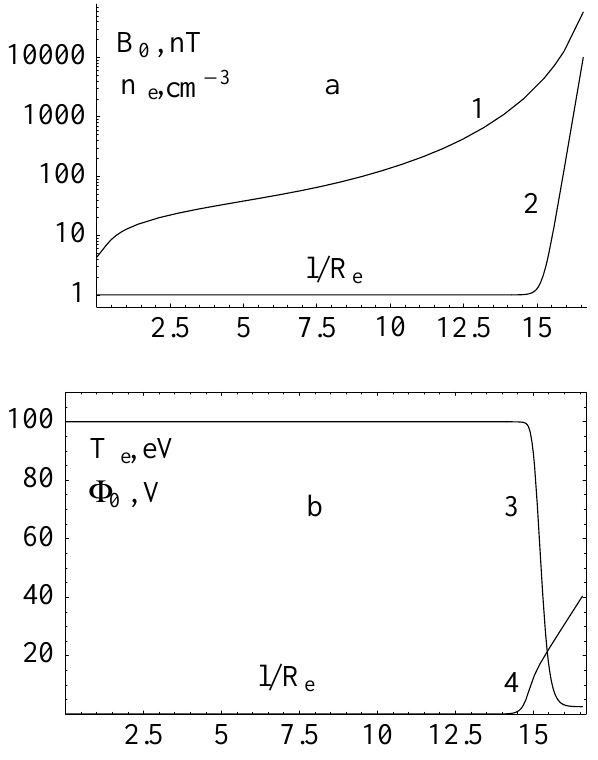
Fig. 10. Variation of the ambient magnetic field (1), plasma den- sity (2), electron temperature (3), and the electrostatic potential (4), along the magnetic field line. The equatorial plane is at l = 0, and the ionospheric end corresponds to l max = 16 . 6 R E , the FAST altitude corresponds to l = 16 R E